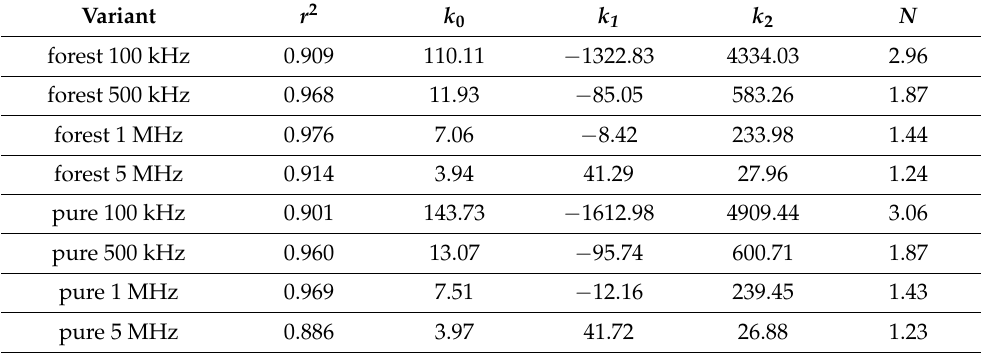
Table 4. Calculated coefficients of the mathematical model based on the Equation (5) and coefficients of